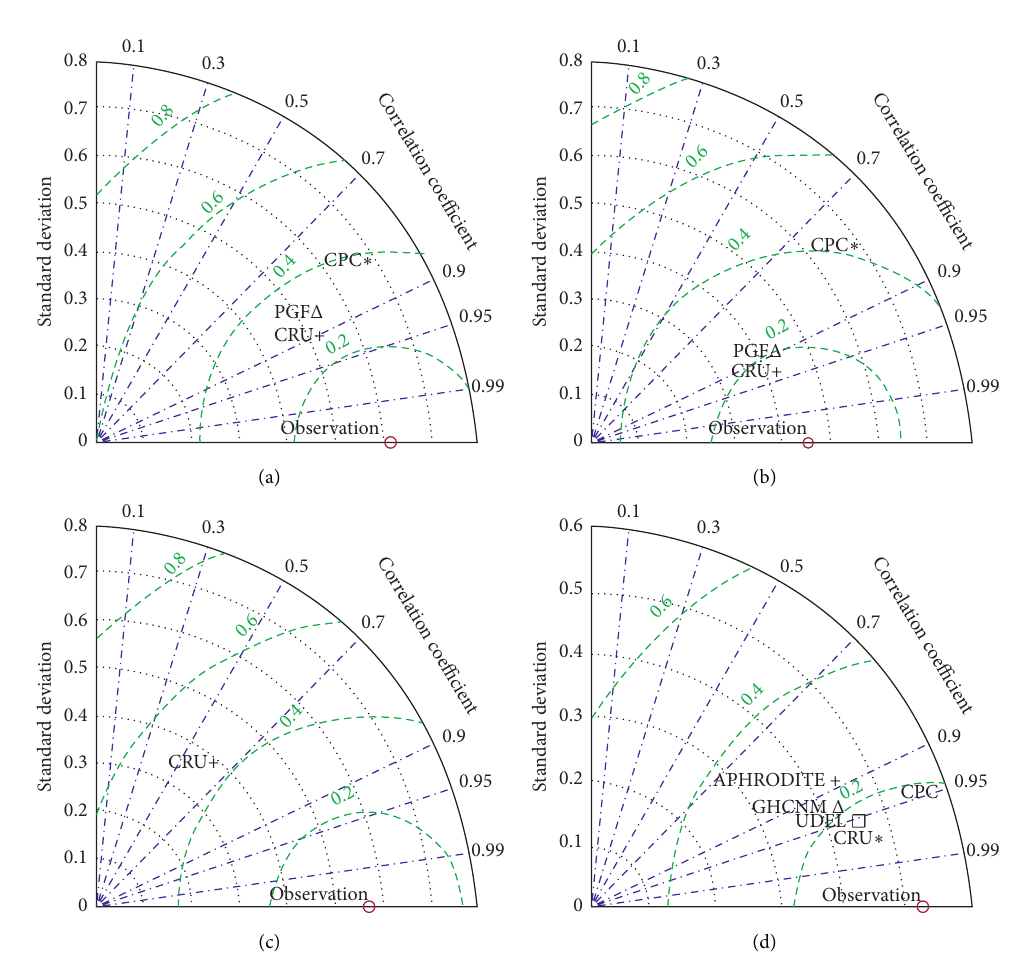
Figure 5: Statistical comparison of observation data and GDPs for (a) T